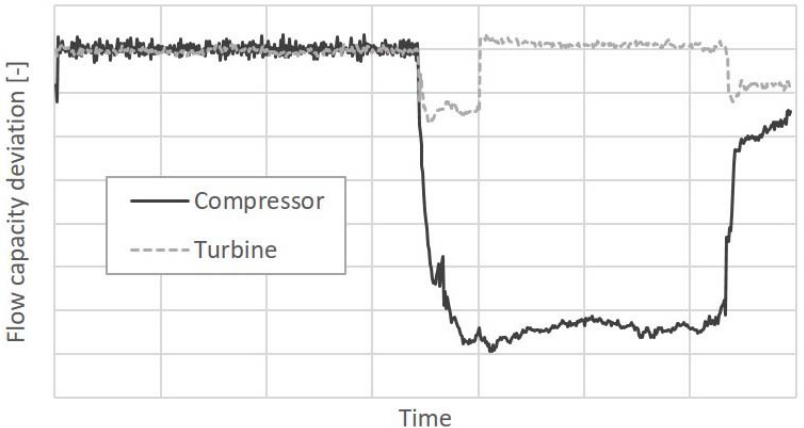
Figure 10. Estimated compressor and turbine flow capacity deviations in day 21 of Scenario 2.